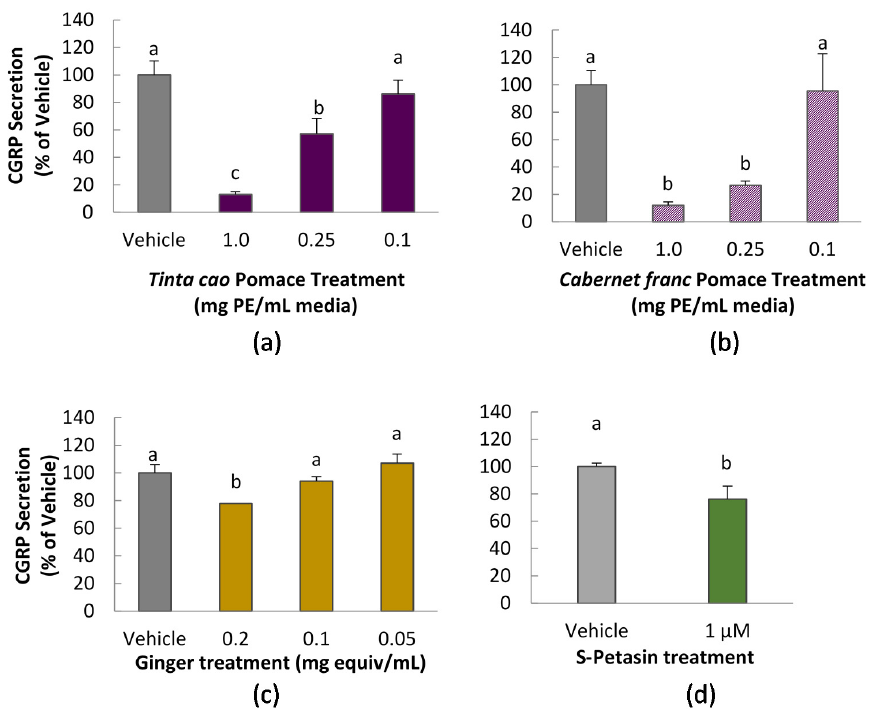
Figure 2. CGRP (Calcitonin gene-related peptide) secretion levels upon treatment with extracts: ( a ) Tinta cao grape pomace extract ( n = 6), ( b ) Cabernet franc grape pomace extract ( n = 6), ( c ) dried ginger root extract ( n = 9), and ( d ) purified S -petasin ( n = 4). CA-77 cells were treated for 1 h with extracts at specified final doses. All treatments contain 0.1% DMSO, including vehicle. Results obtained via commercial ELISA kit. Columns of the same sub-figure marked by the same letter are not statistically different ( P < 0.05).